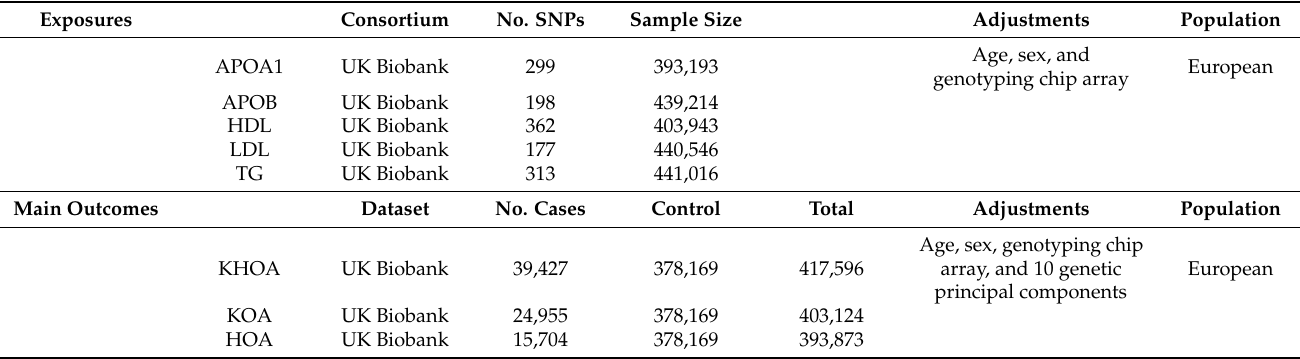
Table 1. Characteristics of UK Biobank